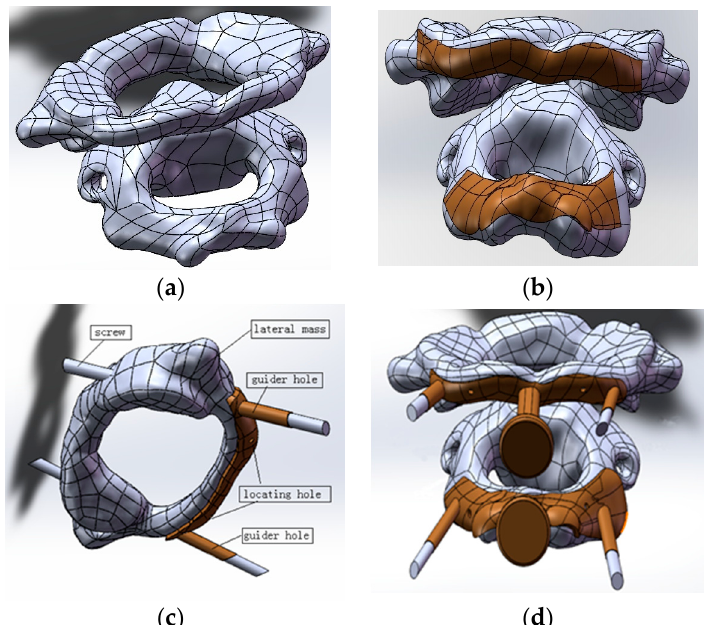
Figure 1. Key steps to design the spinal surgery template. ( a ) Atlas (up) and axis (down); ( b ) curved surface and cervical vertebra; ( c ) guider hole and locating hole; and ( d ) template with the handle and cervical vertebra.